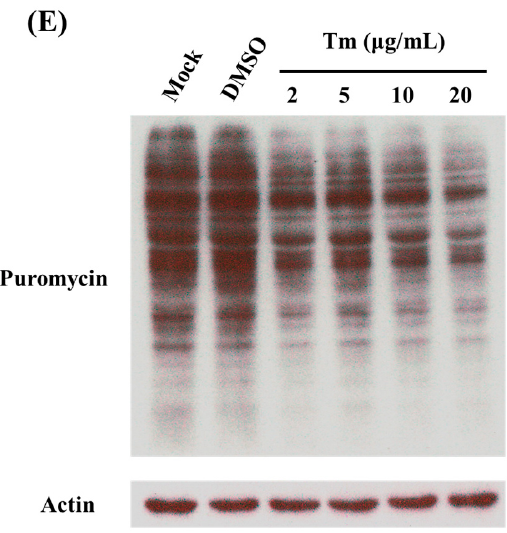
Figure 1. Dengue 2 virus (DENV2)-induced shutdown of total protein translation in C6/36 cells at 24 and 48 h post-infection (hpi). ( A ) Using the method of surface sensing of translation (SUnSET) to monitor and quantify global protein synthesis in infected cells. The mock- and DENV2-infected C6/36 cells were pulse-chase labelled with puromycin for 30 min before cells were harvested. Protein synthesis rate was analyzed by Western blot with an antibody against puromycin. Western blot analysis of actin and Coomassie Blue staining of total cellular protein were included to prove equal protein loading. Results showed that the total protein amount had been reduced by 24 hpi, and this persisted to 48 hpi; ( B ) Histograms represent the quantification of the intensities of puromycin-incorporated bands from three independent experiments. Changes between virus- and mock-infected cells significantly differed at both time points (Student’s t -test; ** p < 0.01); ( C ) The viral NS3 protein was only detected in cells infected by infectious DENV2, not in those inoculated with a UV-inactivated virus according to the results of the immunofluorescent assay; ( D ) The method SUnSET also showed that total protein synthesis decreased in cells infected with untreated DENV2, but there was no obvious change in cells inoculated with a UV-inactivated virus; ( E ) In C6/36 cells treated